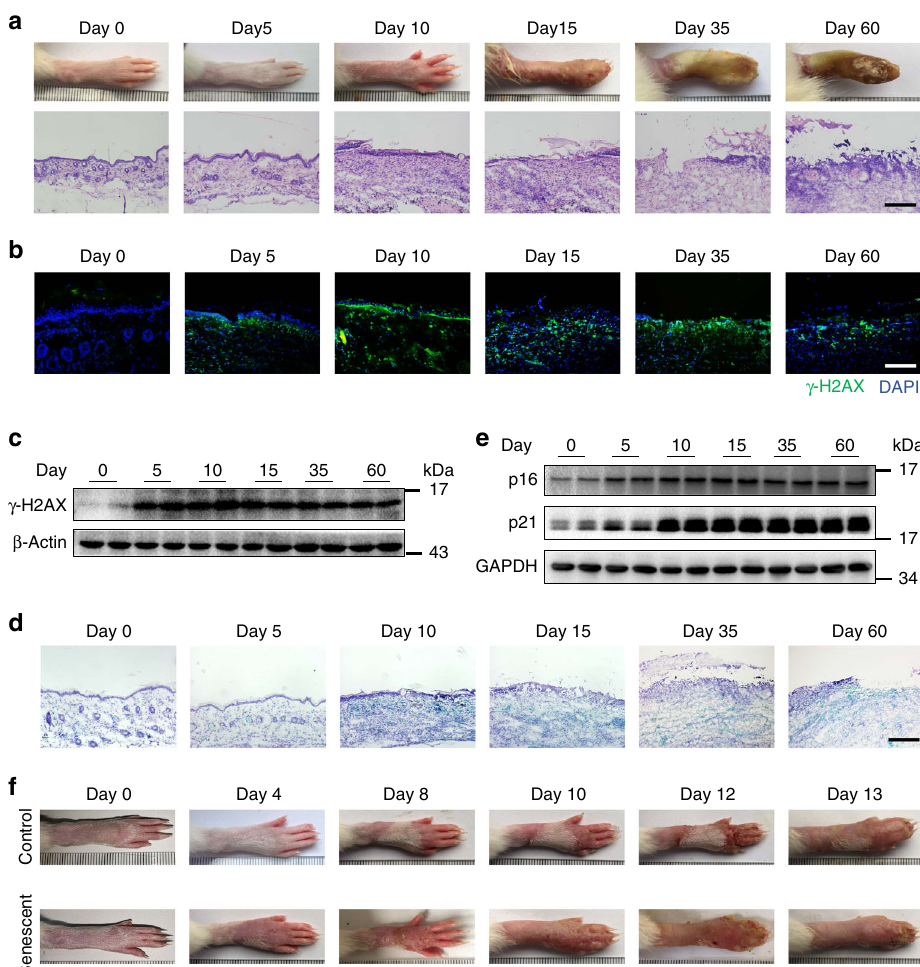
Fig. 1 DNA damage and senescent cell accumulate in radiation ulcer. a Representative images of hind limb 0 – 60 days post-radiation (top), representative histological analysis of rat skin tissues 0 – 60 days post-radiation (bottom). b Representative immuno fl uorescence pictures of γ -H2AX in rat skin